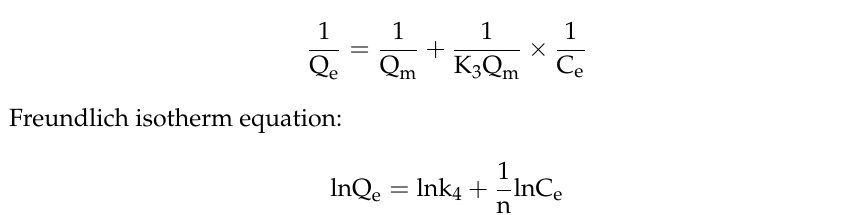
Table 2. Parameters of Langmuir adsorption model and Freundlich adsorption model.